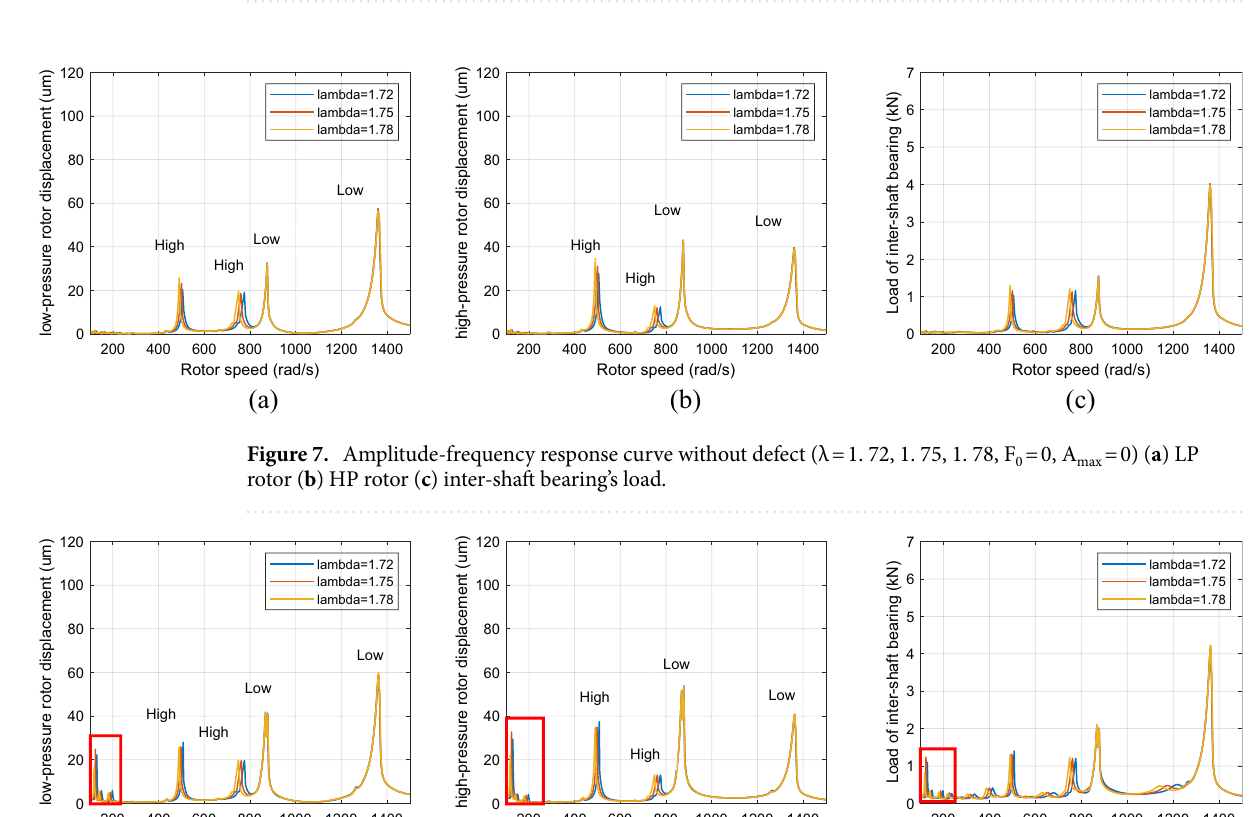
Table 4. Speed ratio of HP and LP under synchronous impact.